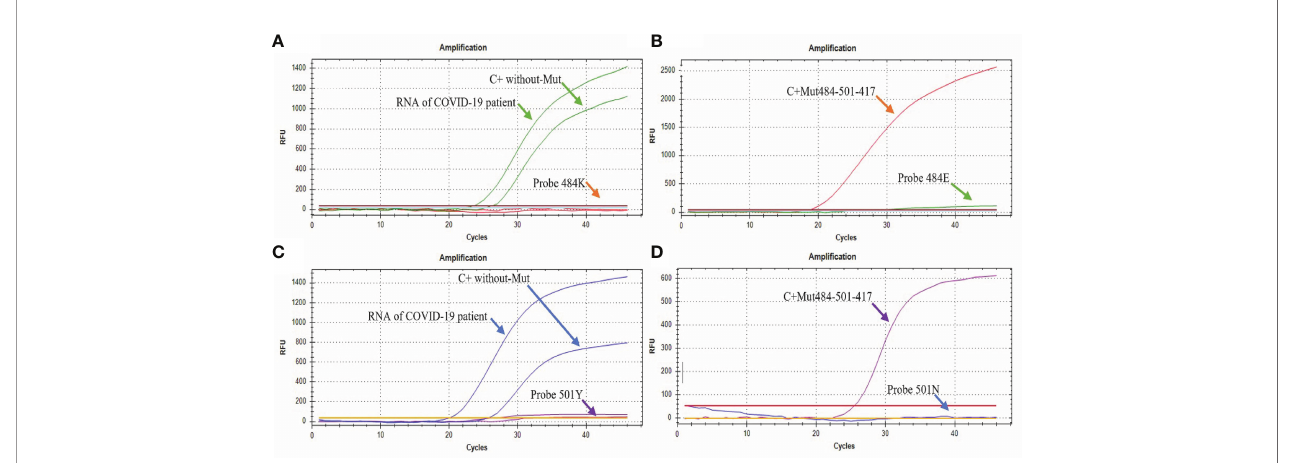
FIGURE 4 | Ampli fi cation curves of the E484K/N501Y Assay. (A) The green curve shows the ampli fi cation of the probe directed to the sequence without the E484K mutation (FAM), while the signal by the probe directed to the sequence that presents the mutation remains without ampli fi cation signal; (B) the orange curve shows the ampli fi cation of the probe directed to the E484K mutation (CFR 610), while the probe directed to the sequence without mutation remains without ampli fi cation signal; (C) the blue curve shows the ampli fi cation of the probe directed to the sequence without mutation N501Y (HEX), while the probe directed to the sequence with the mutation remains without ampli fi cation signal; (D) the purple curve shows the ampli fi cation of the probe directed to the mutation N501Y (Quasar670) with the control containing the mutation (C+ Mut484-501-417), while the probe directed to the sequence without the mutation remains without ampli fi cation